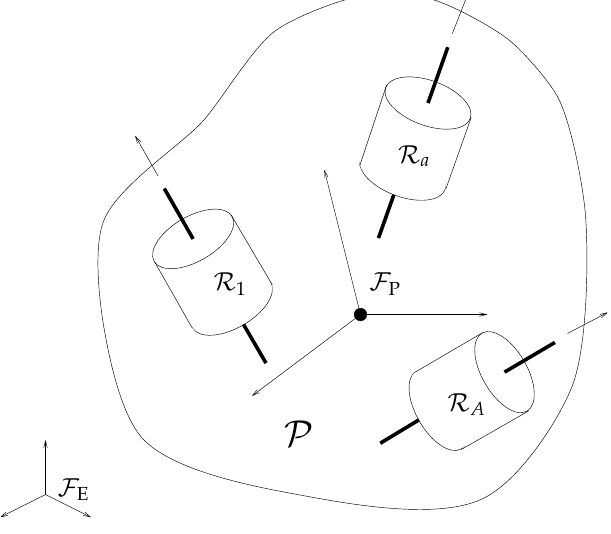
Figure 1. Gyrostat reference frames (adapted from